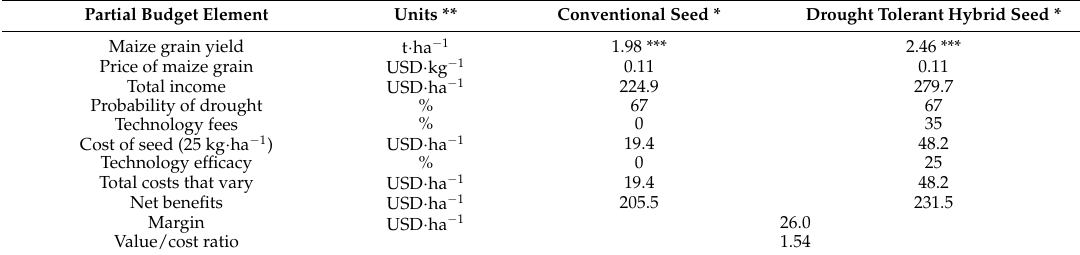
Table 3. Partial budget analysis for the use of drought tolerant genetically modified maize for all farmers.